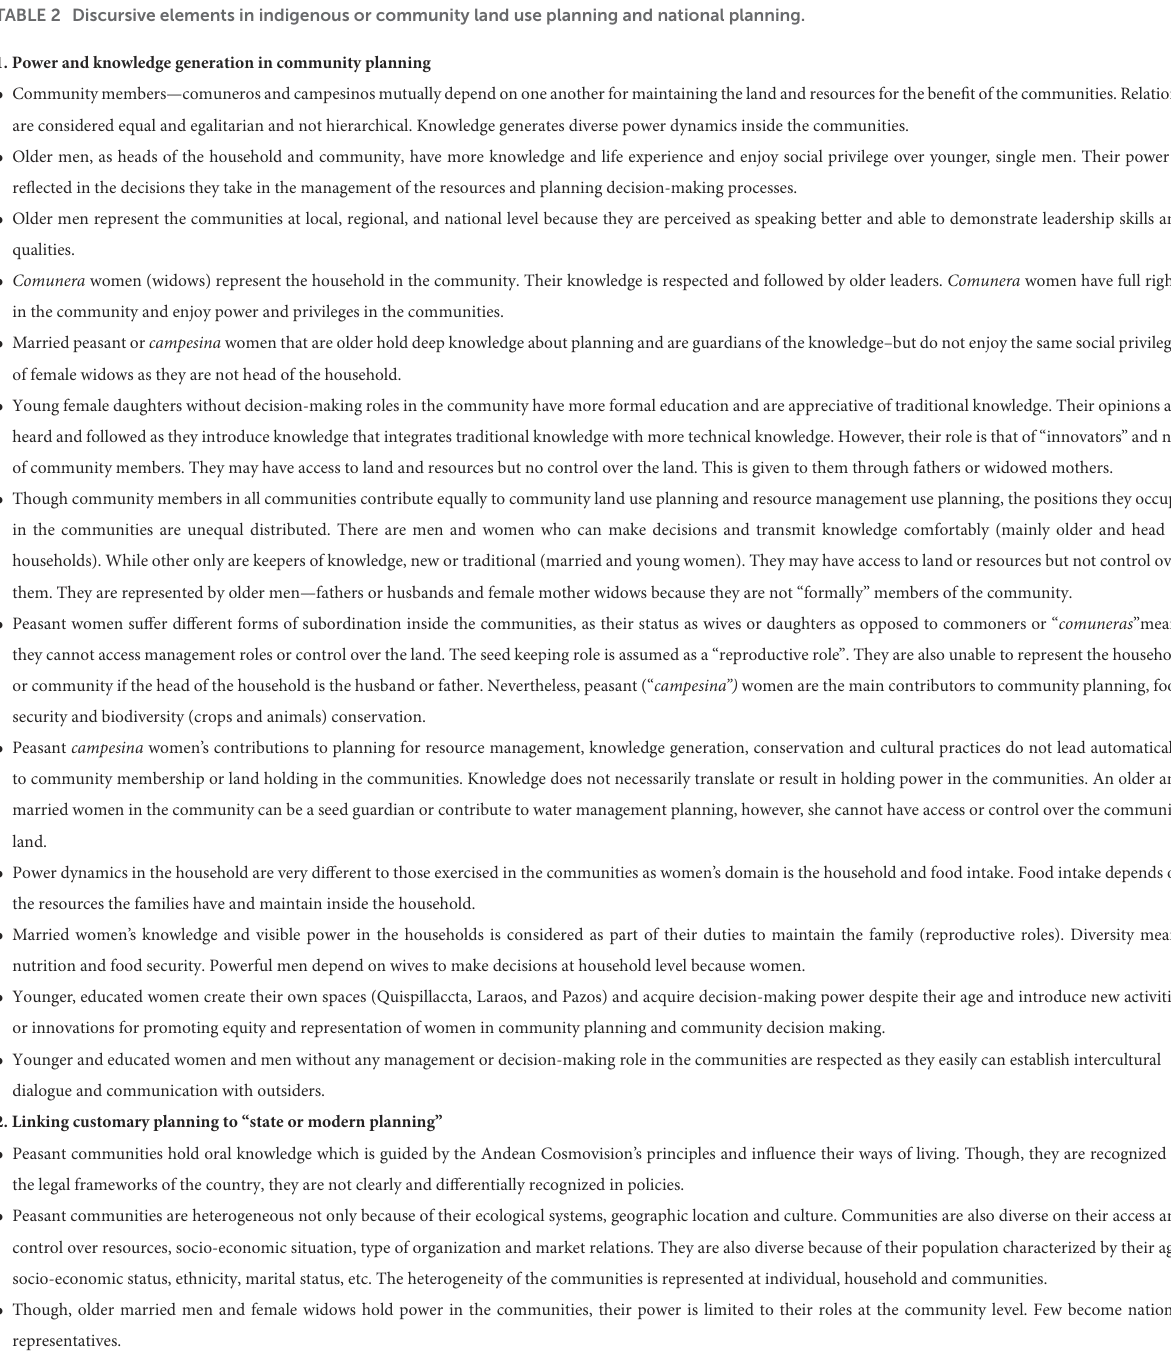
TABLE 2 Discursive elements in indigenous or community land use planning and national